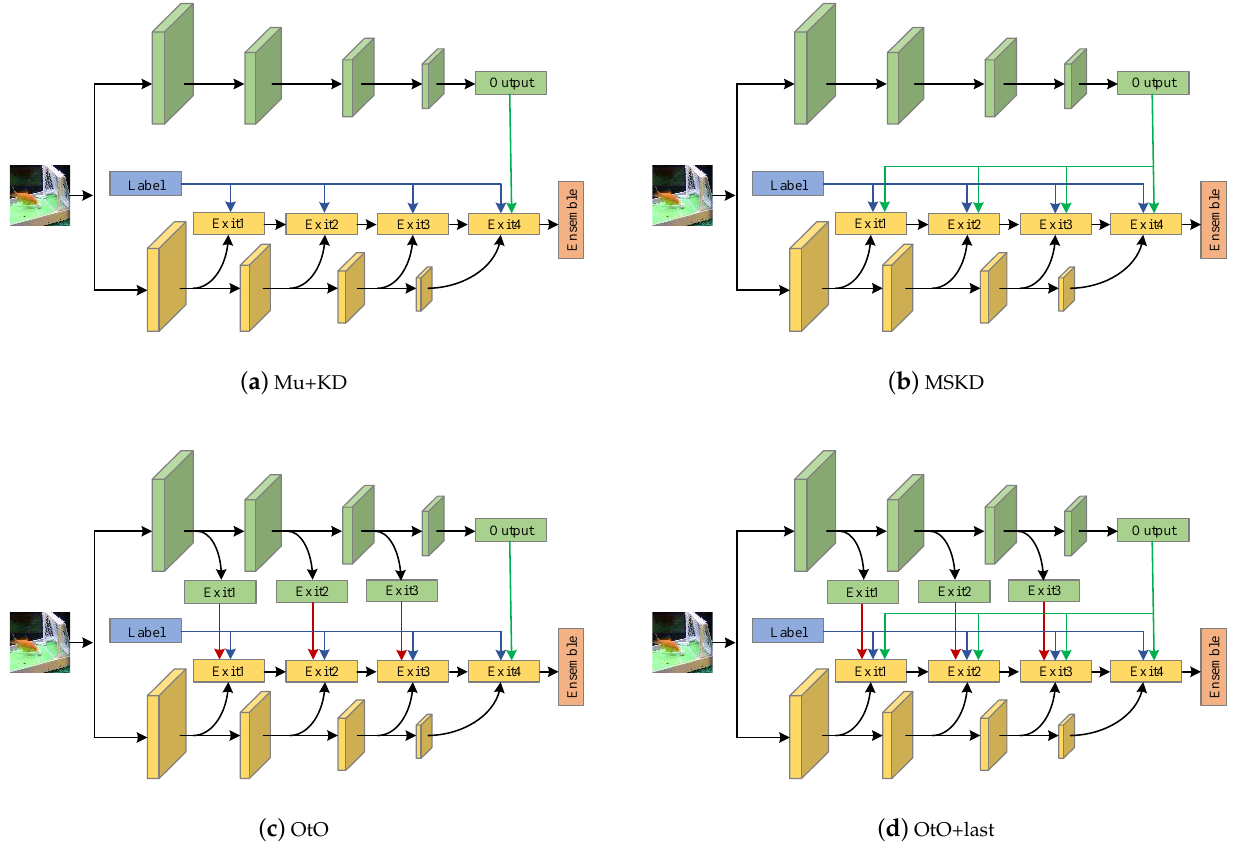
Figure 7. The framework diagram of each method. The blue line indicates the supervision of the true label, the green line indicates the supervision of the teacher network, and the red line indicates the supervision of the early exit of the teacher network. ( a – d ) denote the four training methods mentioned in the context,